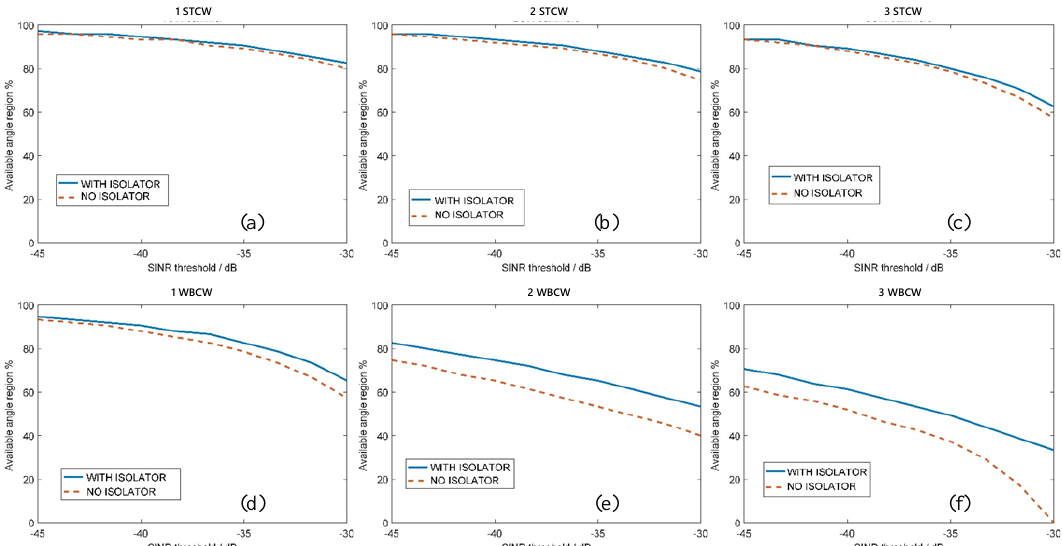
Figure 10. The AARP (representing anti-jamming abilities) varies with different number of Single Tone Continuous Wave (STCW) jammers—( a ) one, ( b ) two, ( c ) three, and Wide Band Continuous Wave (WBCW) jammers—( d ) one, ( e ) two, ( f )